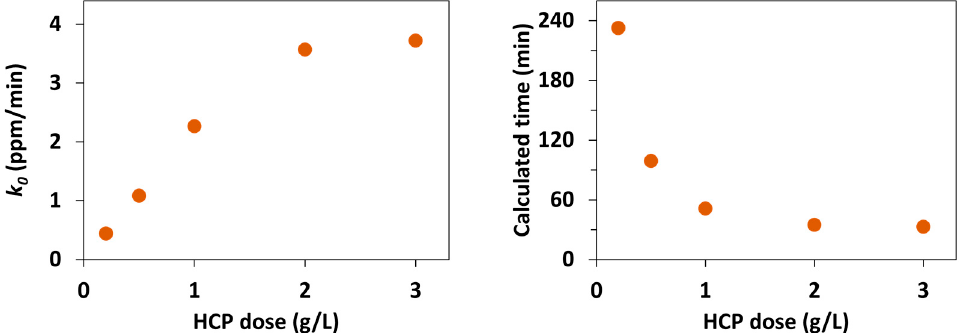
Figure 8. Rate constant ( left ) and calculated time ( right ) of MB degradation using different catechol-